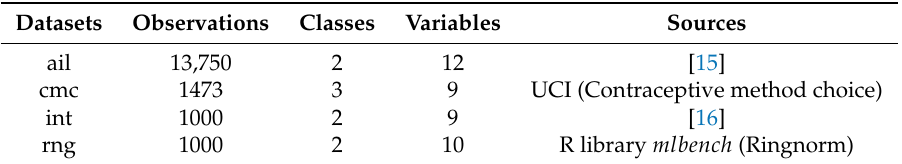
Table 1. The description of 4